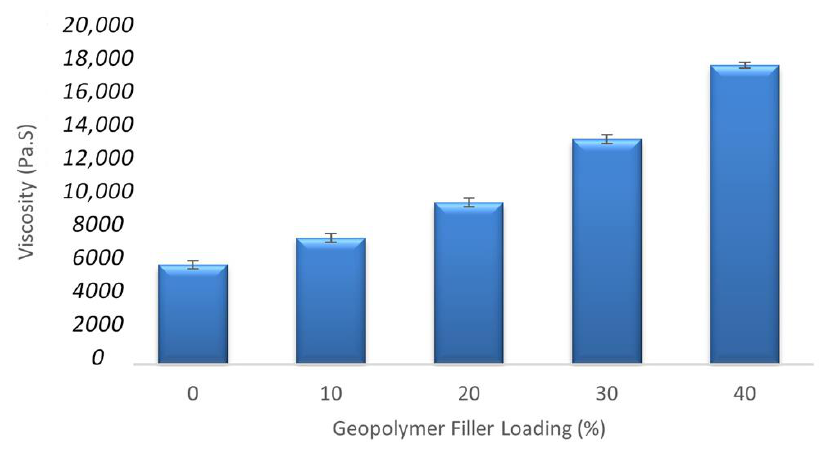
Figure 8. Comparison graph of liquid viscosity between samples.